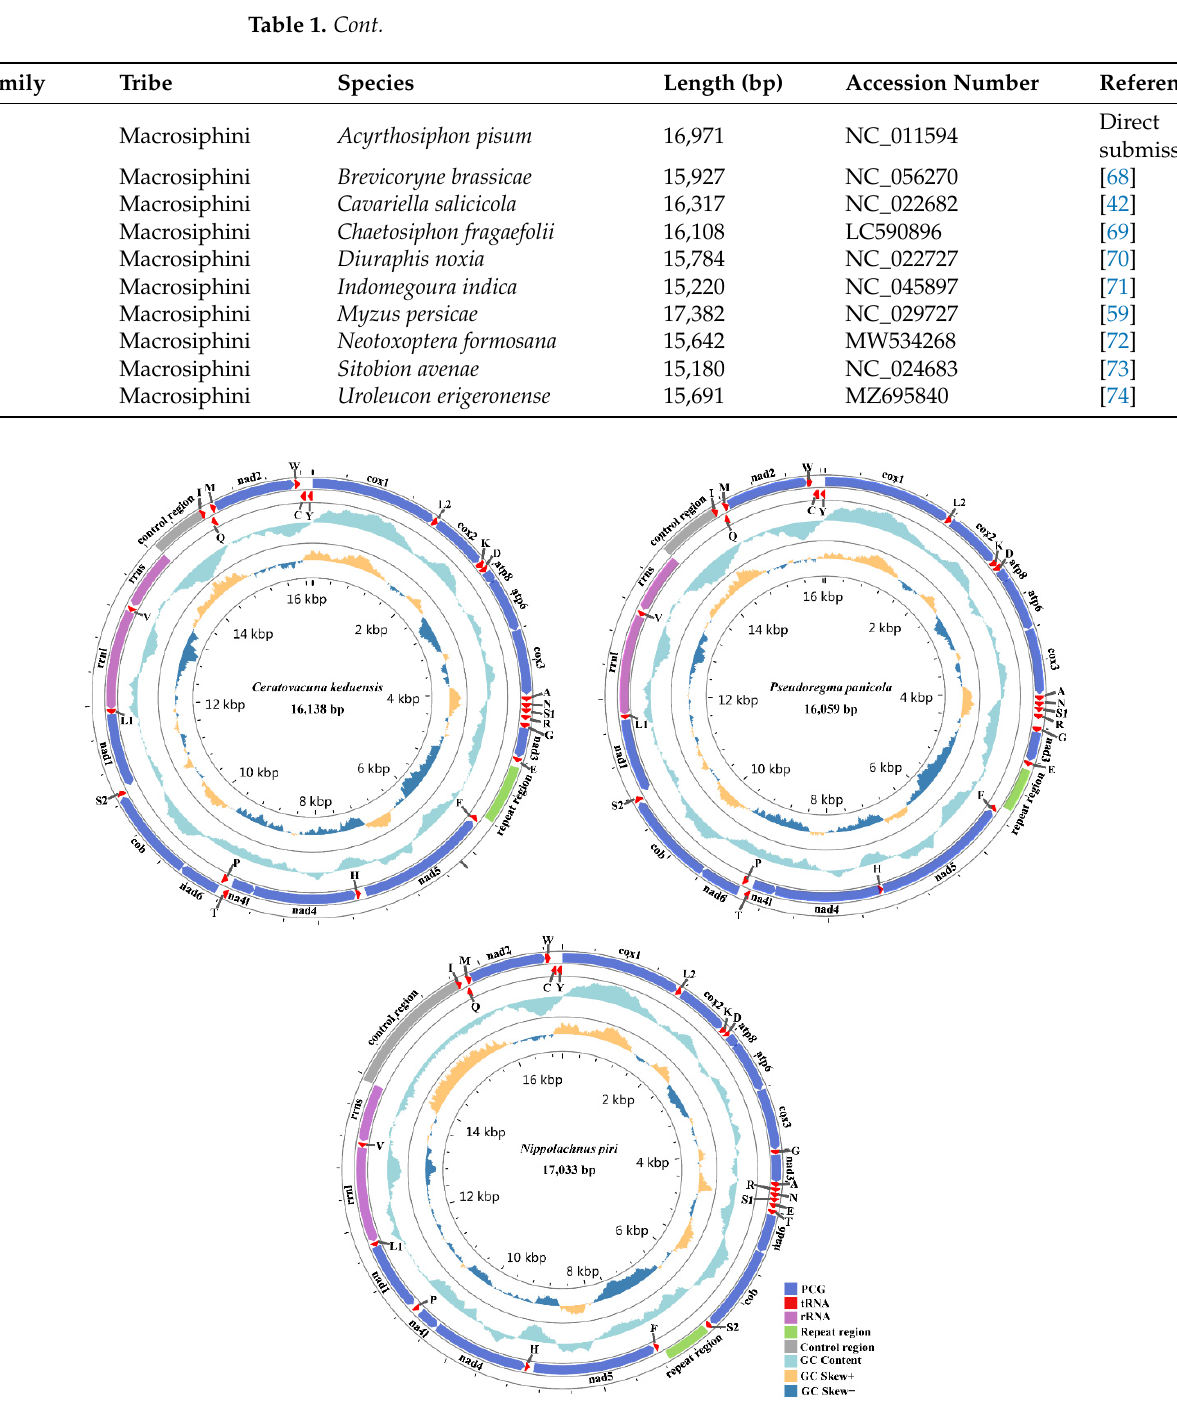
Figure 1. Circular maps of mitogenomes for Ceratovacuna keduensis , Pseudoregma panicola , and Nippolachnus piri . Genes or gene regions are highlighted by different colors. The tRNAs are indicated by single-letter amino acid codes. The outermost circle shows the gene arrangement with arrows indicating the direction of transcription. The second circle indicates the GC content with the celeste shading above and below denotes GC content values greater than and less than the genome average, respectively. The third circle indicates the GC skew with the light orange shading above, and indigo blue shading below denotes GC skew values greater or less than the genome average, respectively. The innermost circle with scale shows nucleotide position on the genome.